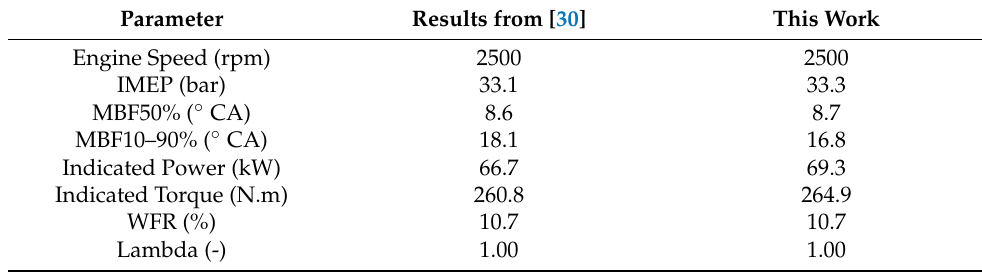
Table 6. Combustion and knock model